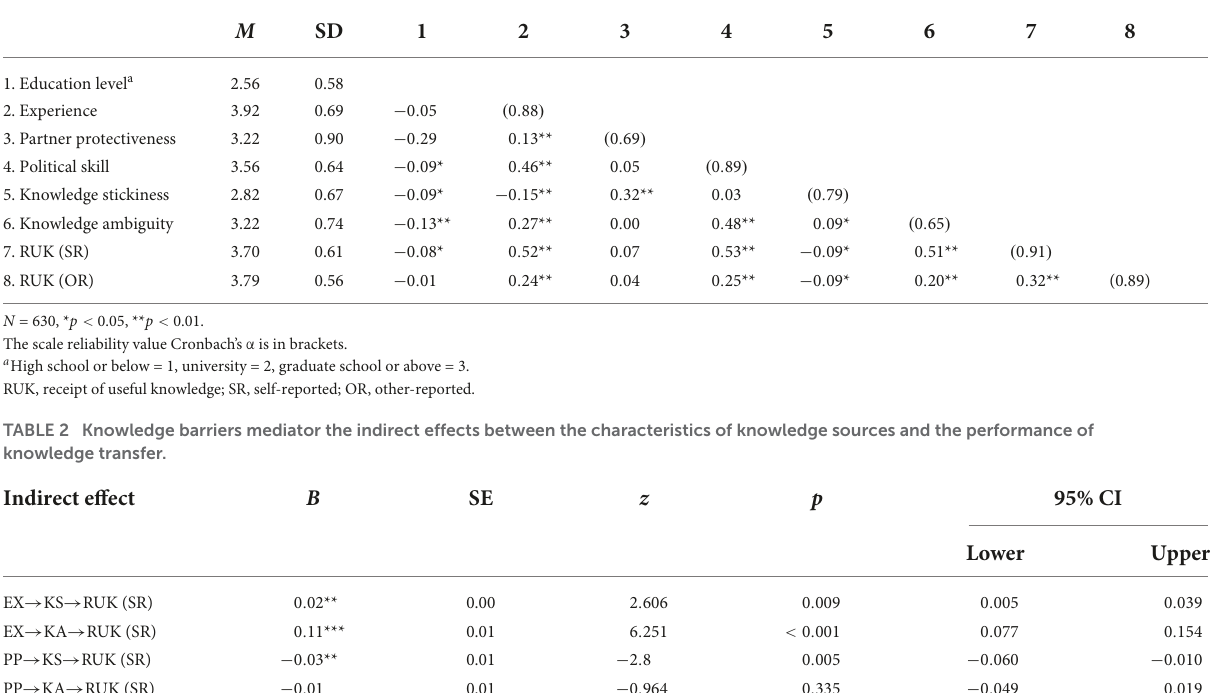
TABLE 1 Mean, standard deviation, and correlations.